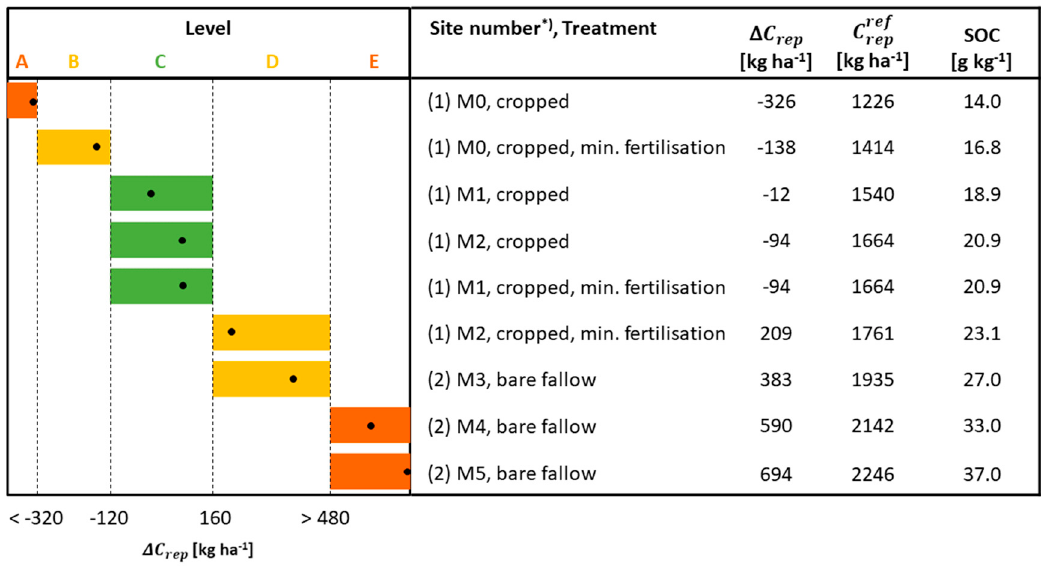
Figure 3. Assessment of selected treatments of LTFEs at Bad Lauchstädt ( * ) (site number as given in Table 1). BAT = 28 d year –1 . Levels A–E relate to the VDLUFA classification as shown in Table 2. Colored bars symbolize the class range and dots represent the actual values of the treatment.